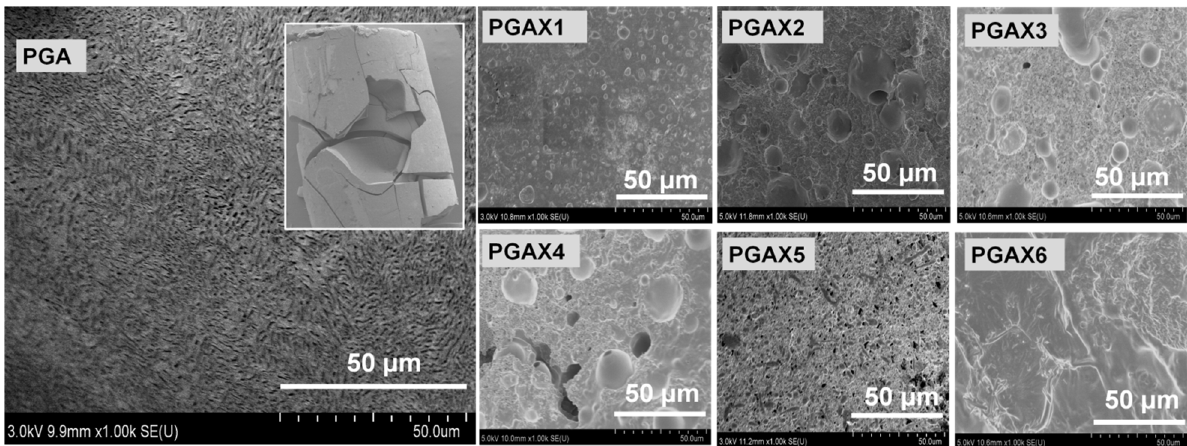
Figure 10. Surface morphology of PGA and PGAX1–6 after water dissolution process in this work.